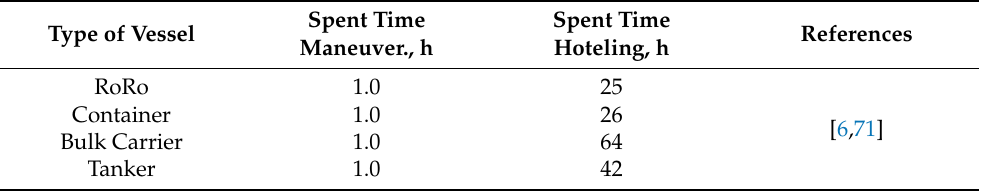
Table 4. Maneuvering and hoteling time (h) for each ship type. Data adapted from [6,71].